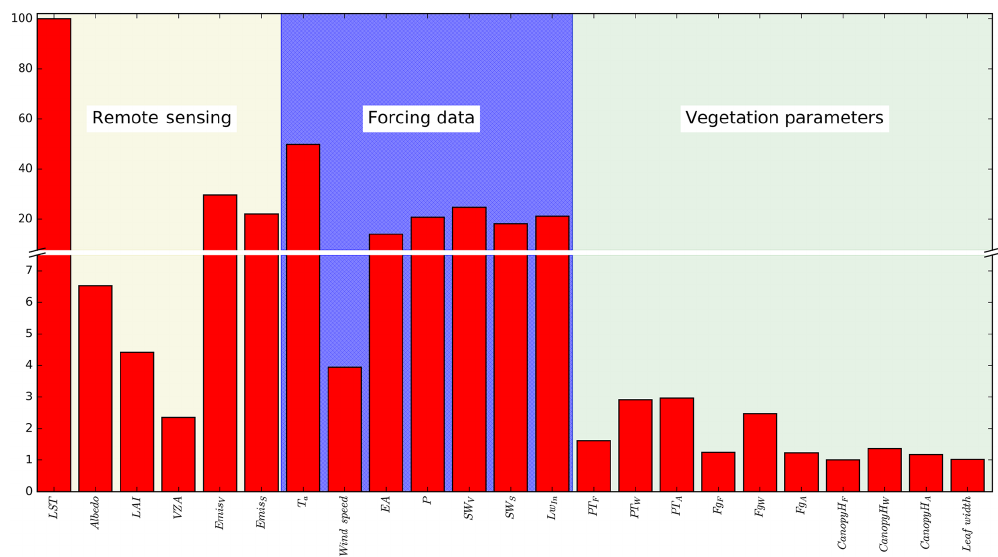
Figure 3. Sensitivity of 28 TSEB model inputs obtained with PEST. Results are normalized using the most sensitive parameter as reference. Acronyms used include LST (land surface temperature), LAI (leaf area index), VZA (view zenithal angle), Emiss V (emissivity of vegetation), Emiss S (emissivity of soil), T A (air temperature), EA (water vapor pressure above canopy), P (atmospheric pressure), SW V (shortwave incoming radiation for vegetation), SW S (shortwave incoming radiation for soil), LW In (longwave incoming radiation), PT F (Priestley– Taylor parameter for forest), PT W (Priestley–Taylor parameter for meadow), PT A (Priestley–Taylor parameter for agriculture), Fg F (fraction of green vegetation for forest), Fg W (fraction of green vegetation for meadow), Fg A (fraction of green vegetation for agriculture), CanopyH F (canopy height for forest), CanopyH W (canopy height for meadow) and CanopyH A (canopy height for